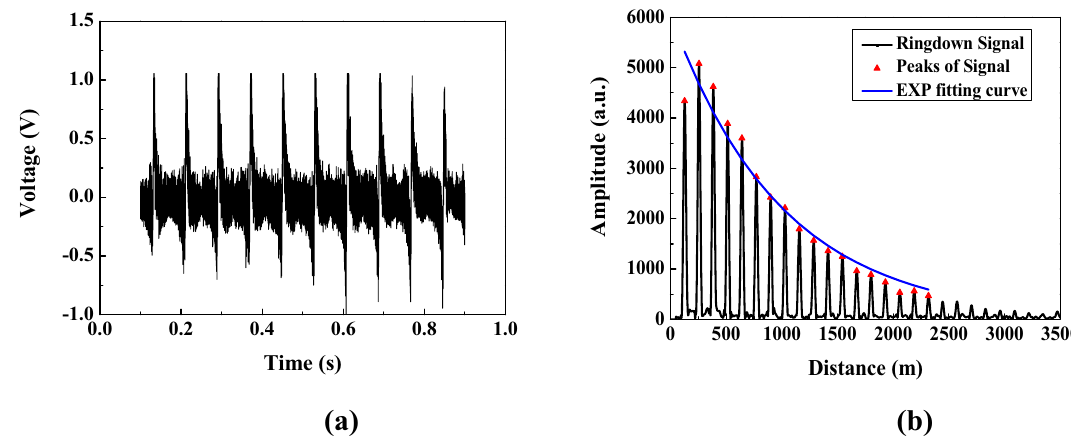
Figure 4. The typical signals measured by the space-domain active FCRD technique. (a) The time-domain differential interference signal; (b) the corresponding ringdown transient in the space domain.